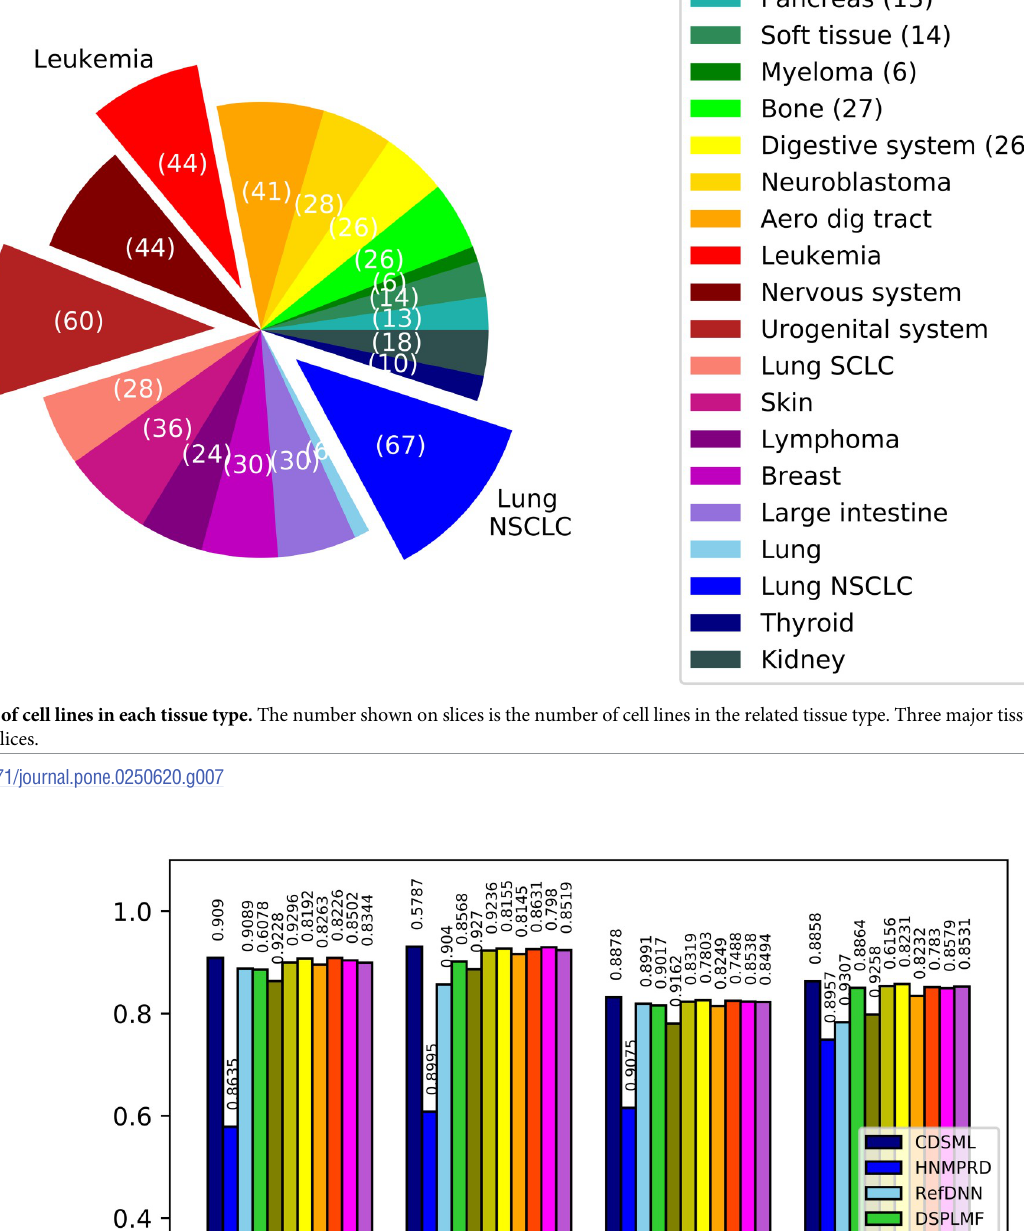
PLOS ONE | https://doi.org/10.1371/journal.pone.0250620 April 29,